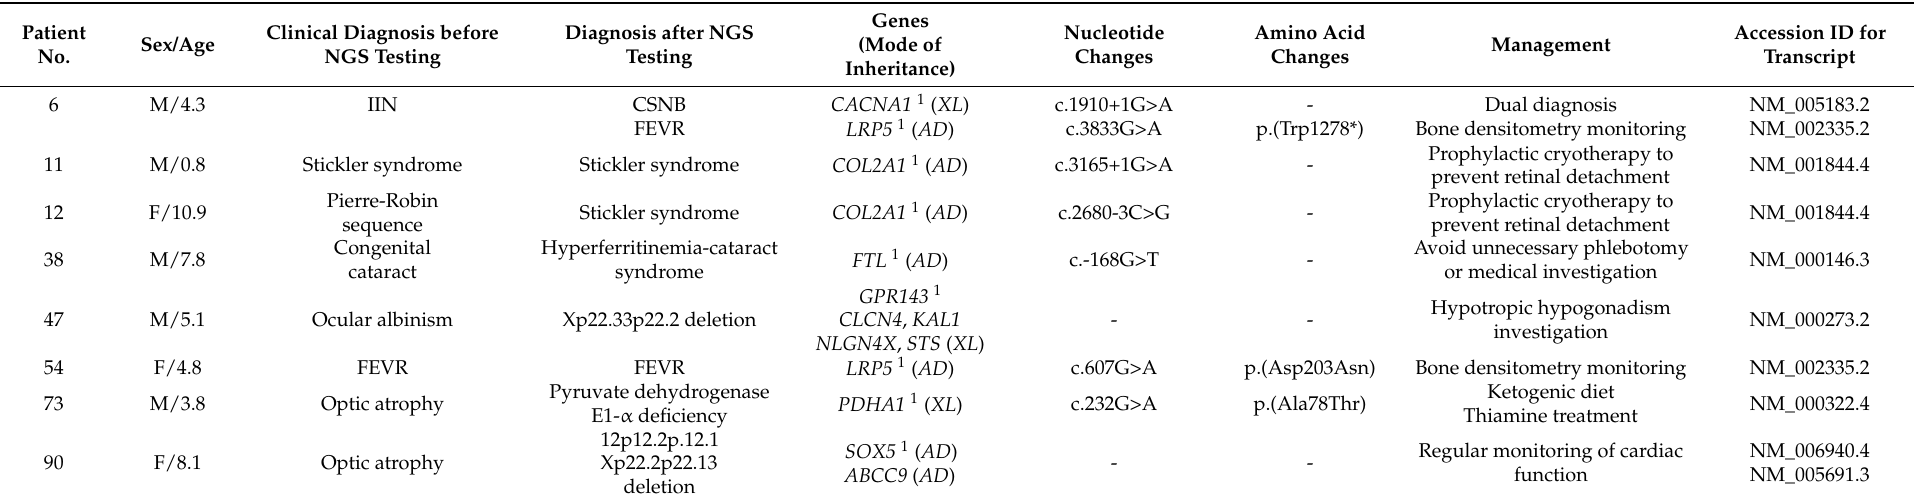
Table 2. Eight patients who were received precision care after targeted next-generation